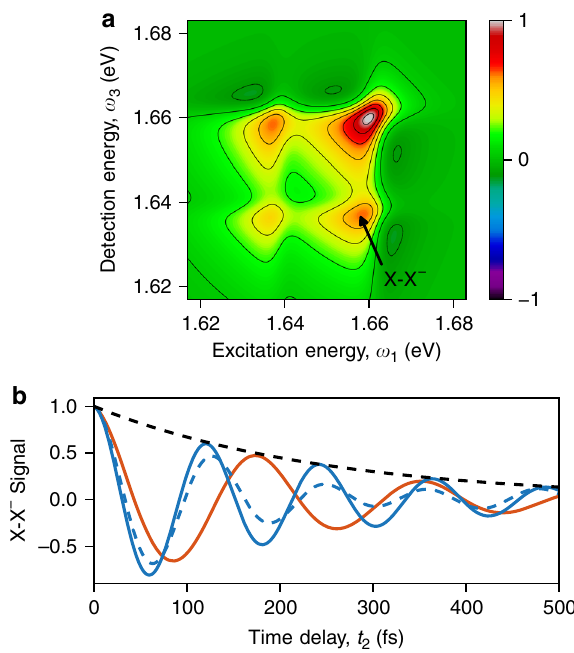
Fig. 3 Exciton – trion quantum beats in two-dimensional spectroscopy. a Total (singlet plus triplet) trion two-dimensional electronic spectrum of monolayer MoSe 2 , calculated through Eq. (3) at zero time delay ( t 2 = 0 fs). b Time-dependent signal at the lower cross-peak (X – X − ) location for MoSe 2 (red) and WSe 2 (blue), shown together with an exponential indicating the phenomenological exciton – trion coherence decay (black dashed). For WSe 2 , results are shown for fully degenerate singlet and triplet trions (solid), and for which the triplet trion is blue-shifted by 7 meV as a result of exchange interactions (dashed). Shown in all cases are the real (absorptive) part of the complex